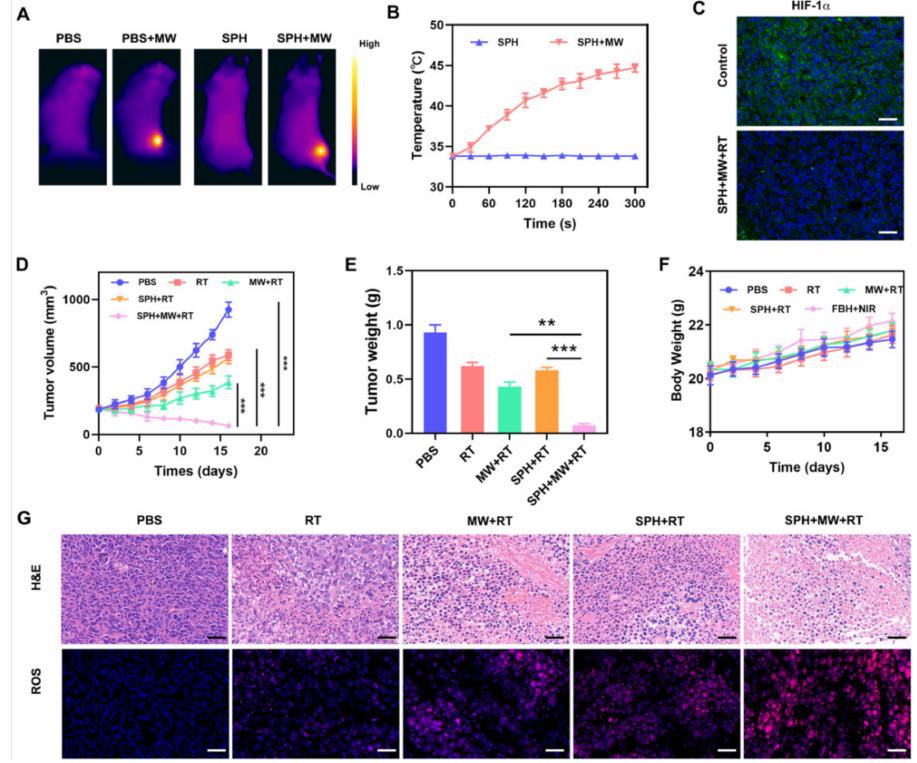
Figure 4. ( A ) Infrared thermal images of tumors in the specified treatment groups of 4T1 tumor- bearing mice before and after 5 min of MW (0.9 W) radiation (n = 5). ( B ) Temperature curves of 4T1 tumor-bearing mice in the specific treatment group within 5 min of MW (0.9 W) radiation (n = 5). ( C ) HIF-1 was immunofluorescence-detected in the indicated treatment groups (n = 5). ( D ) Tumor volume and ( E ) tumor weight following the indicated treatments (n = 5). ( F ) Body weight following the indicated treatments (n = 5). ( G ) HPF and H&E-stained tumor sections from the indicated treatment groups (n = 5). Scale bars: 100 µ m. ** p < 0.01, *** p < 0.005; Student’s t -test.